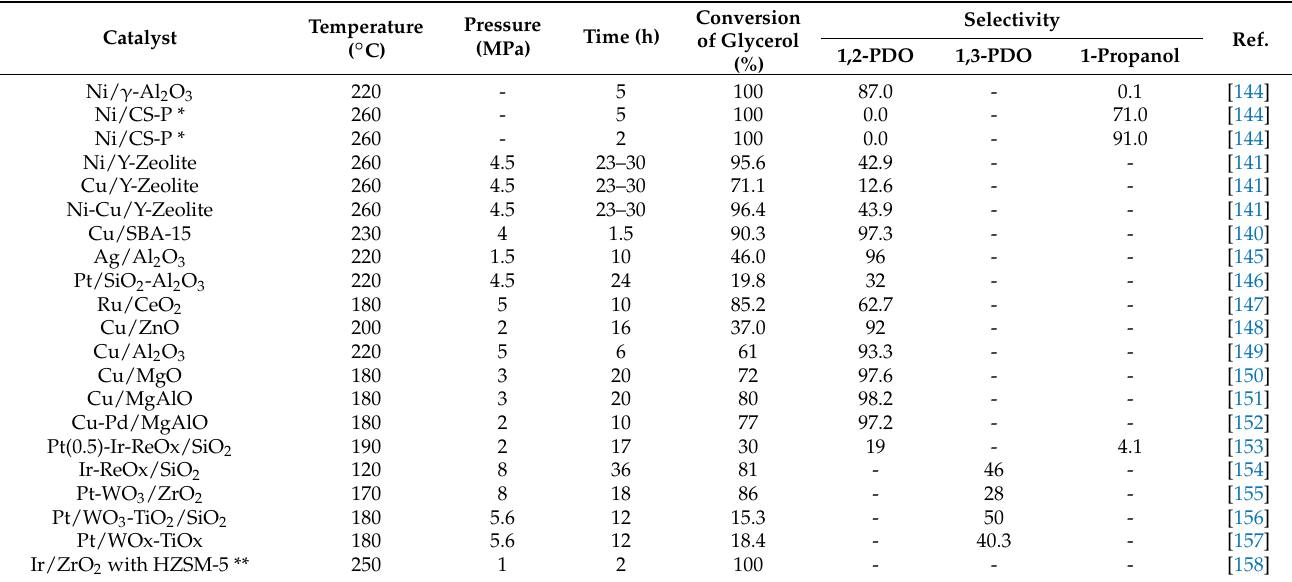
Table 5. Performance of different catalysts used in hydrogenolysis of